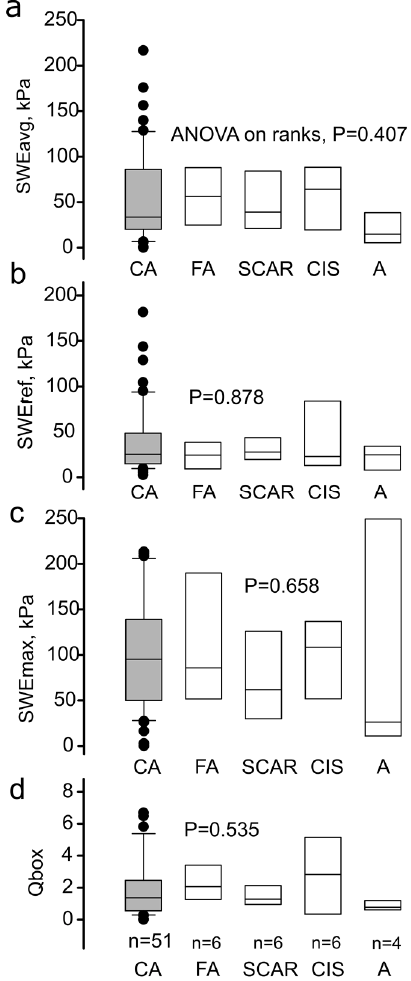
Figure 6. Average SWE metrics of the inbound tumor ROI. ( a ) Average stiffness from target ROI within the B-mode tumor boundaries, ( b ) average stiffness from reference surrounding fat tissue region, ( c ) maximum stiffness from target ROI, and ( d ) Q-box ratio for cancer (CA, n = 62 patients) and benign lesions (n = 32 patients). Box plots show the median and interquartile range, dots within the 5–95th percentile. FA, fibroadenoma; SCAR, scar; CIS, cancer in situ; A, adenosis. ( a – d ) p > 0.05, Kruskal–Wallis ANOVA on ranks.